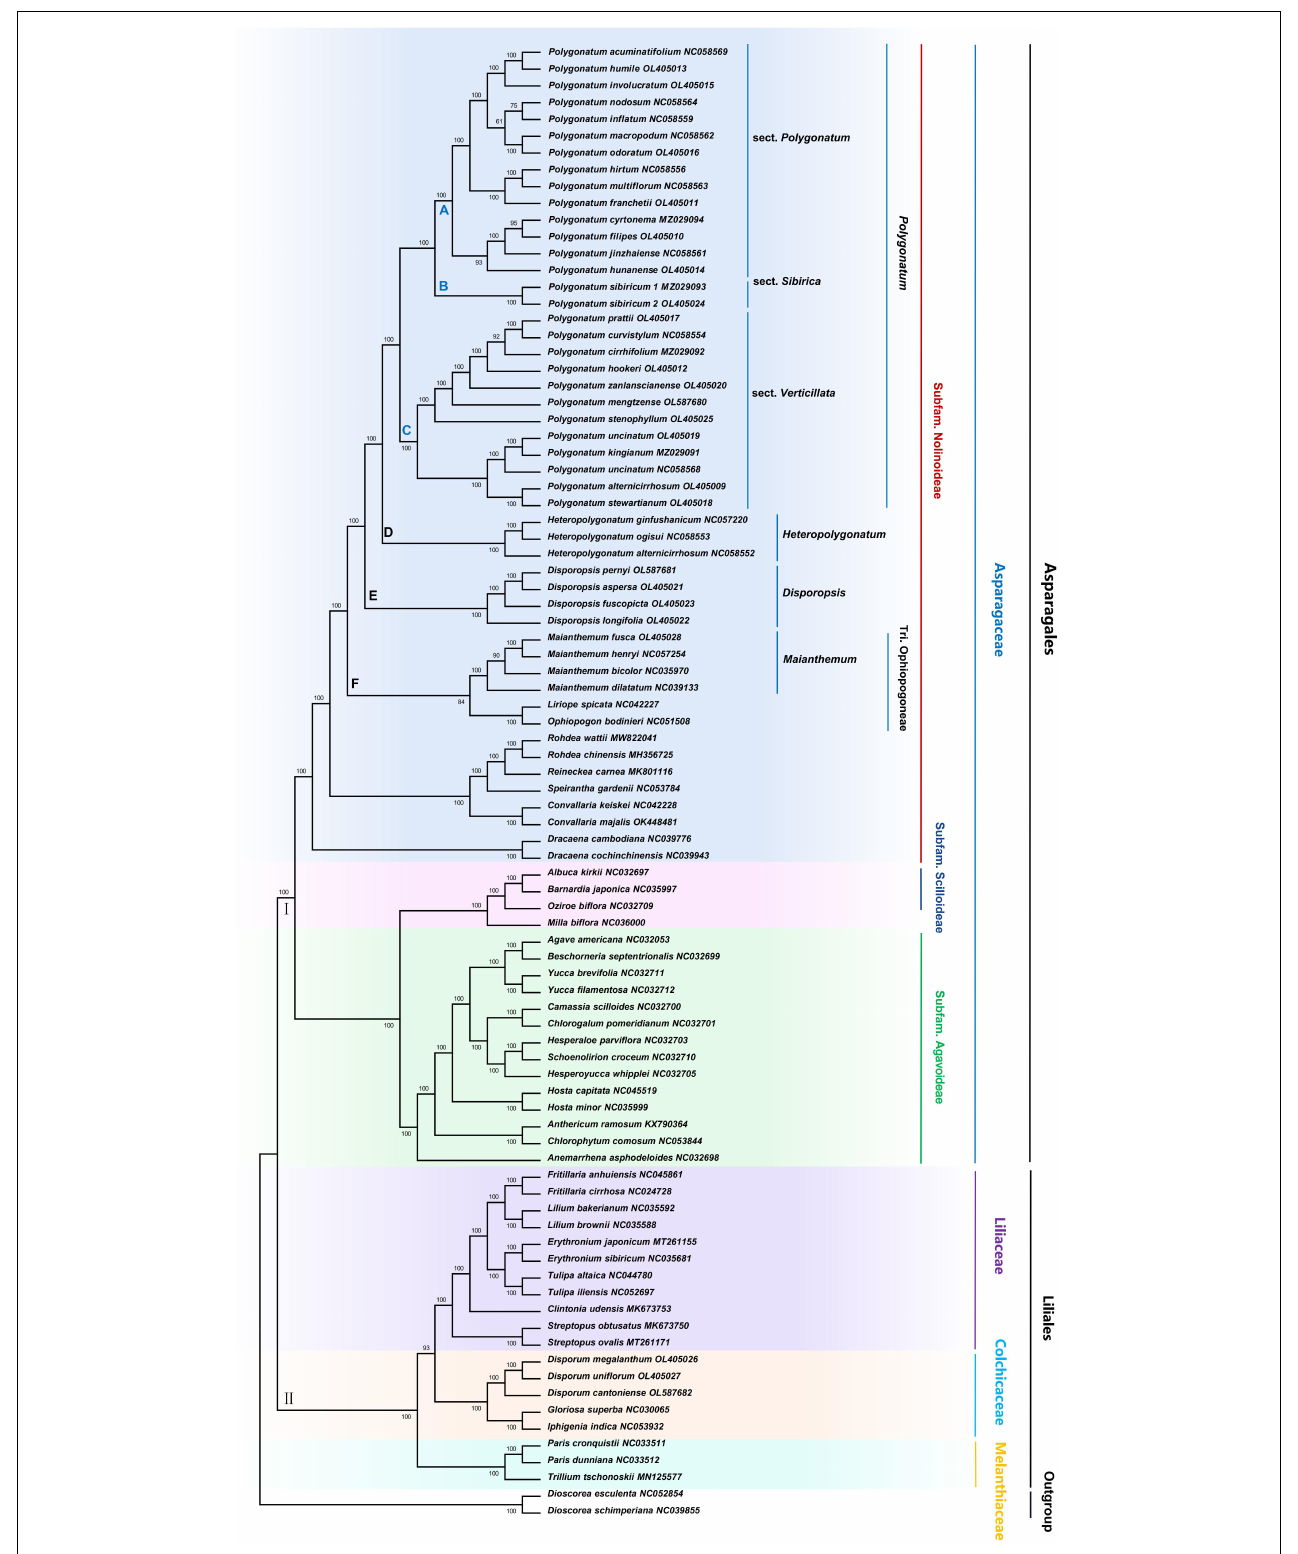
FIGURE 4 | Maximum likelihood phylogenetic tree based on complete cp genome. Dioscorea esculenta and D. schimperiana were used as outgroups. Numbers at nodes are bootstrap support values.